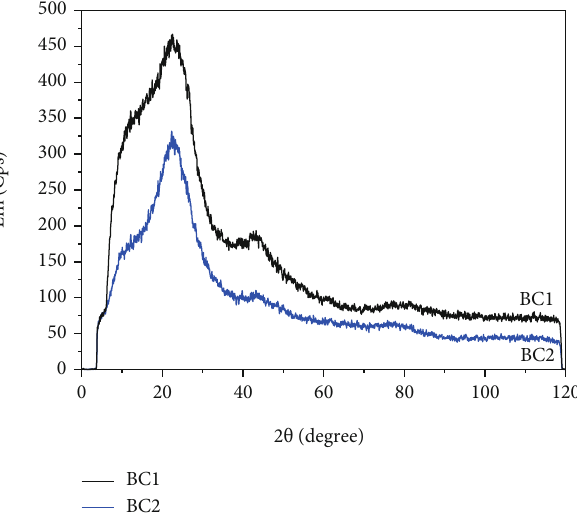
Figure 5: Di ff raction diagram of biochars 1 and